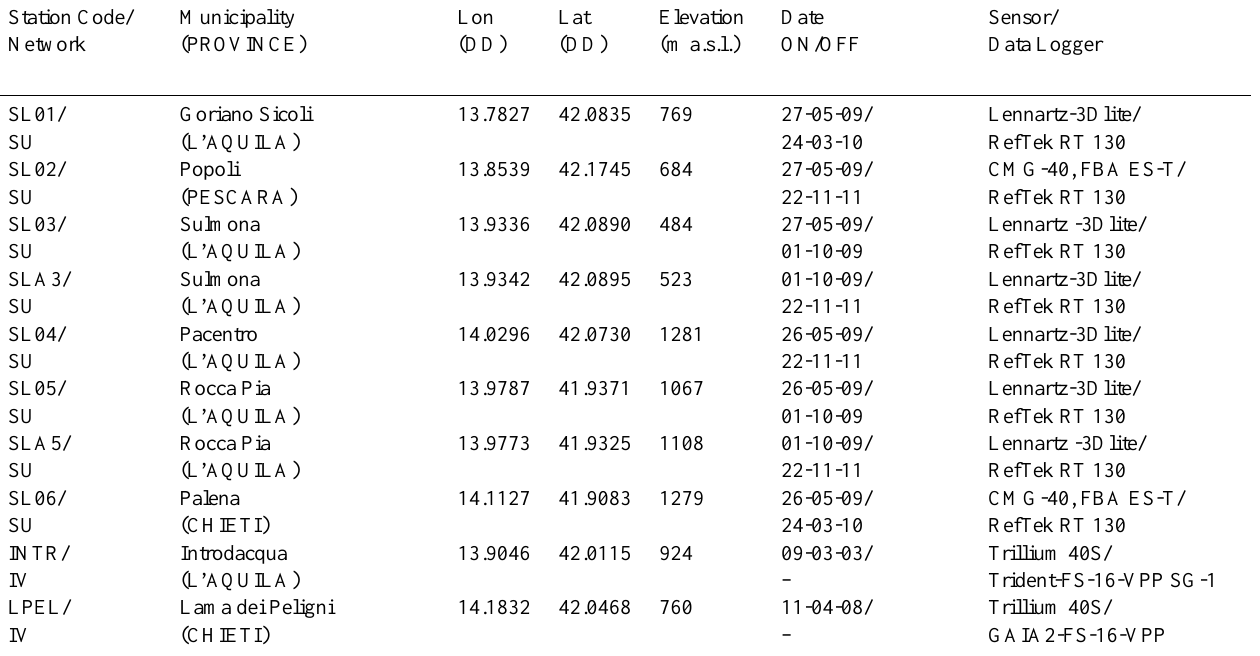
Table 1. Main characteristics of the Sulmona Temporary Network: data taken from the OGS and INGV sites’ archives. SLA is the identifi- cation code of relocated SL0